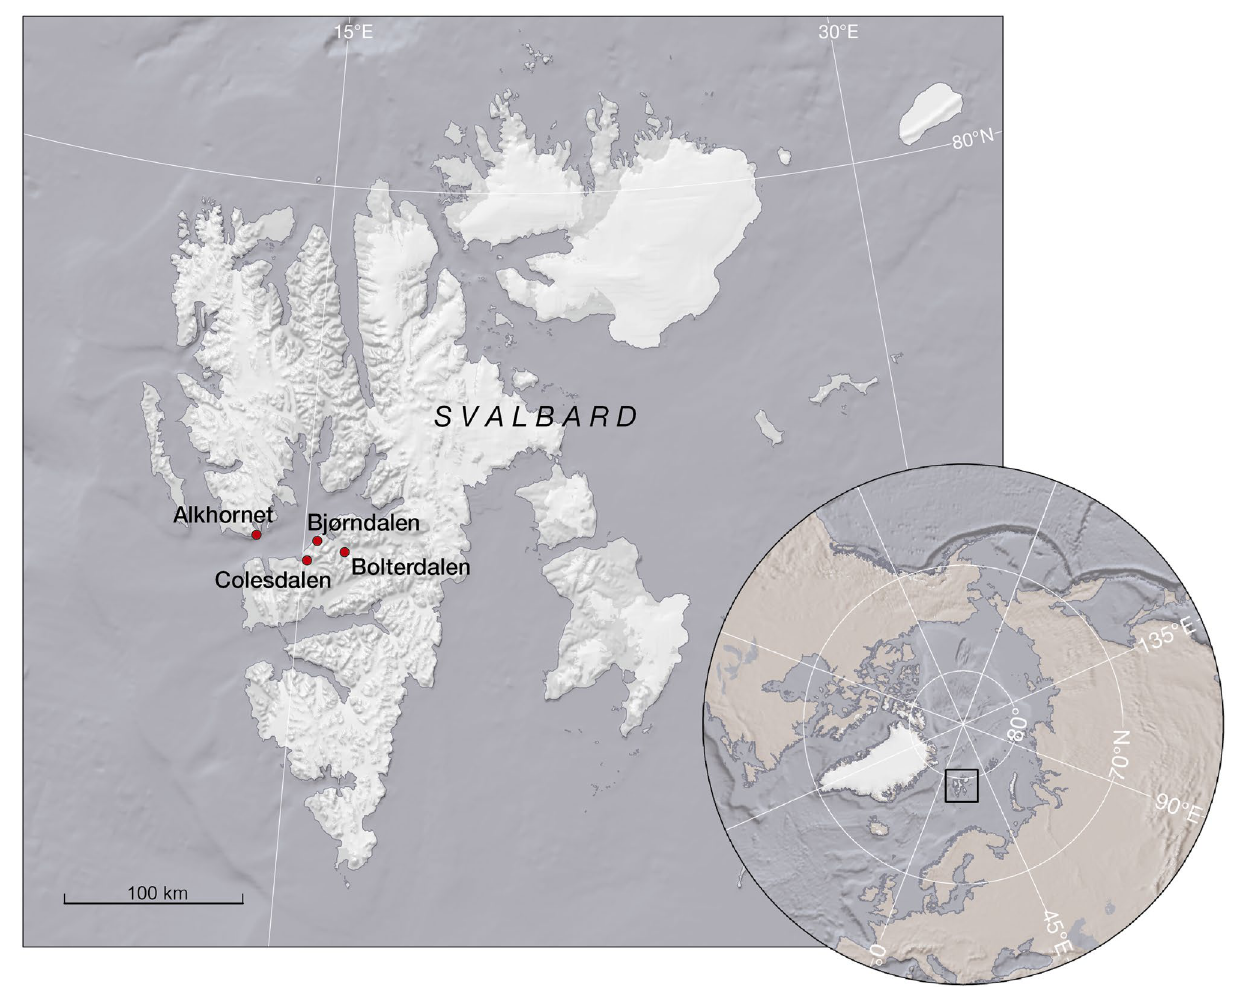
Figure 1. The Svalbard archipelago and location of our study sites in Spitsbergen, the main island of the Svalbard.